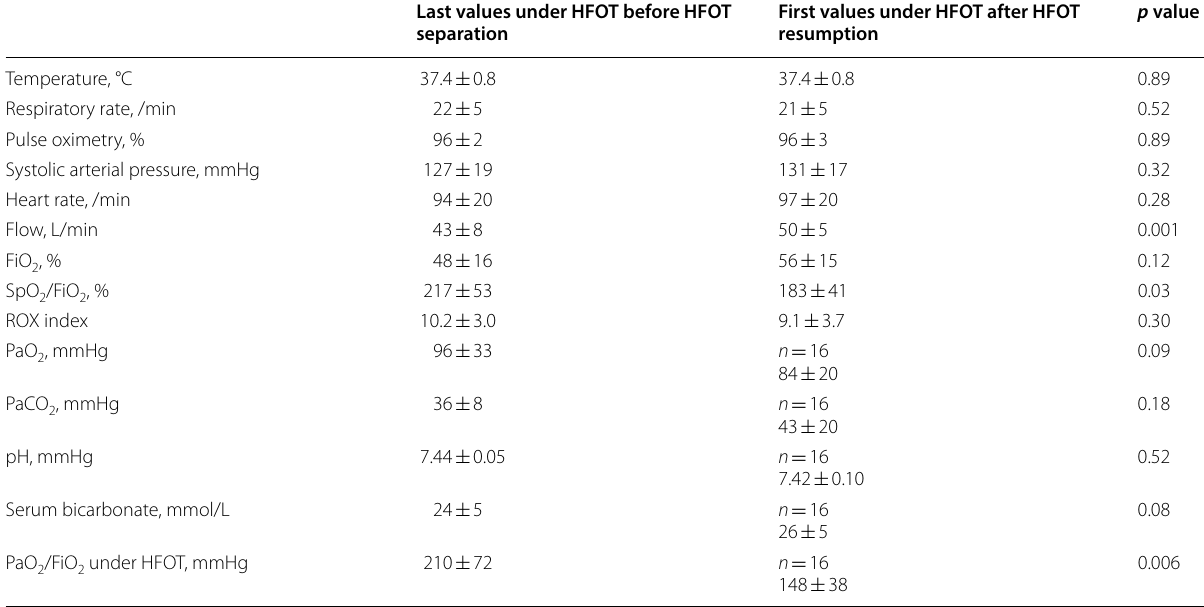
Table 3 Clinical and biological parameters under high-flow nasal oxygen therapy in the failure group, before separation and after